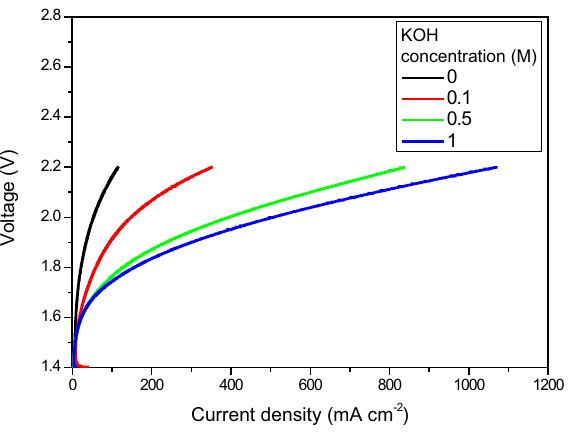
Figure 7. Polarization curves of an AEM electrolyser, recorded for different concentrations of KOH electrolyte, at 60 °C.